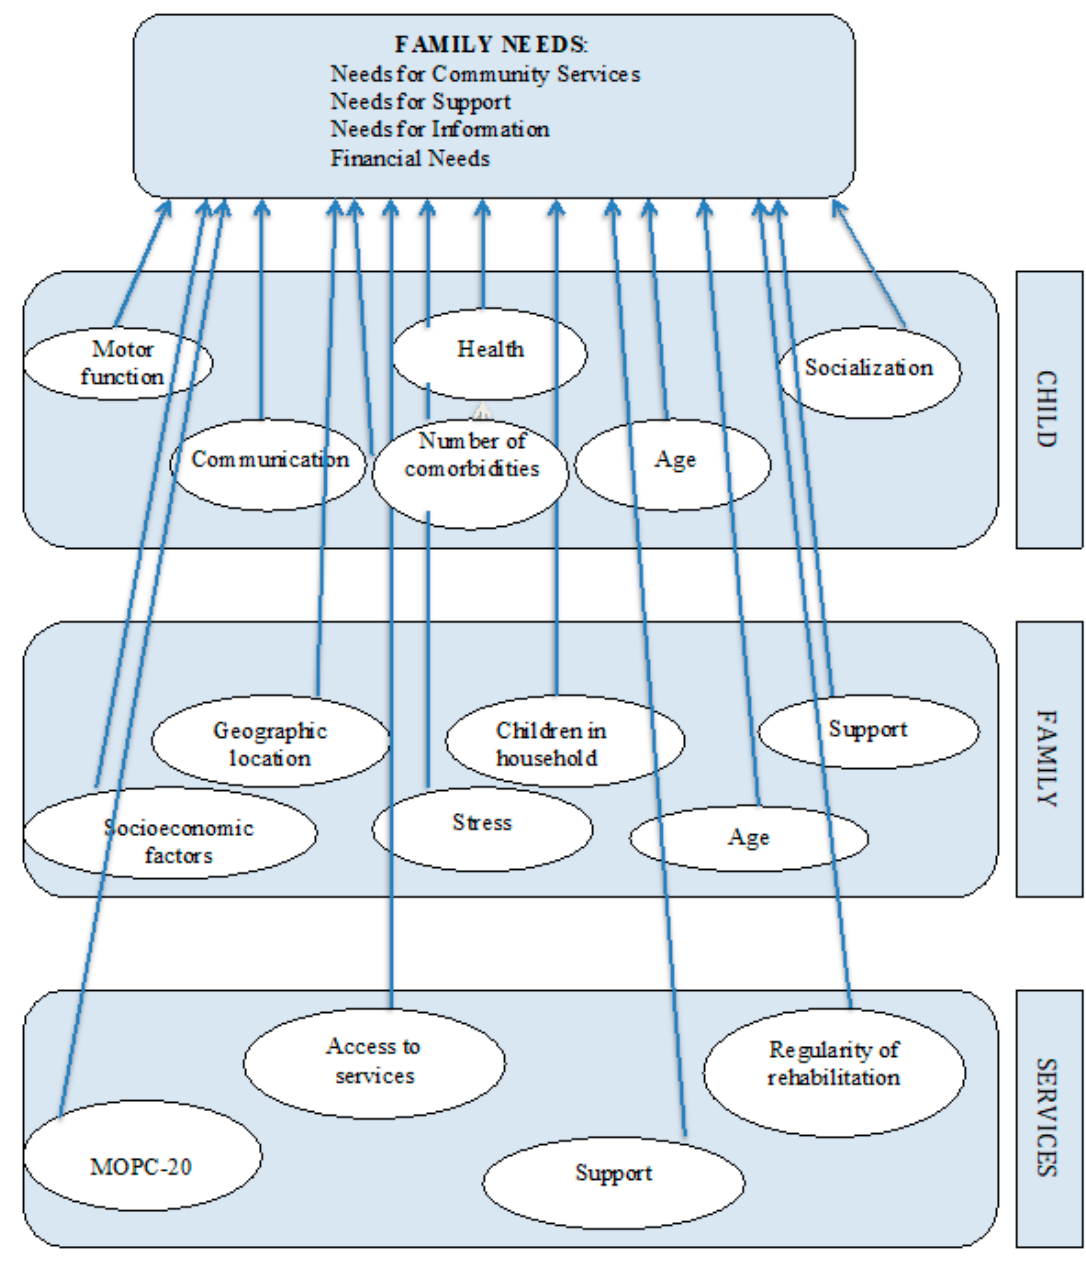
Figure 1. Model of the Determinants of Family Needs.